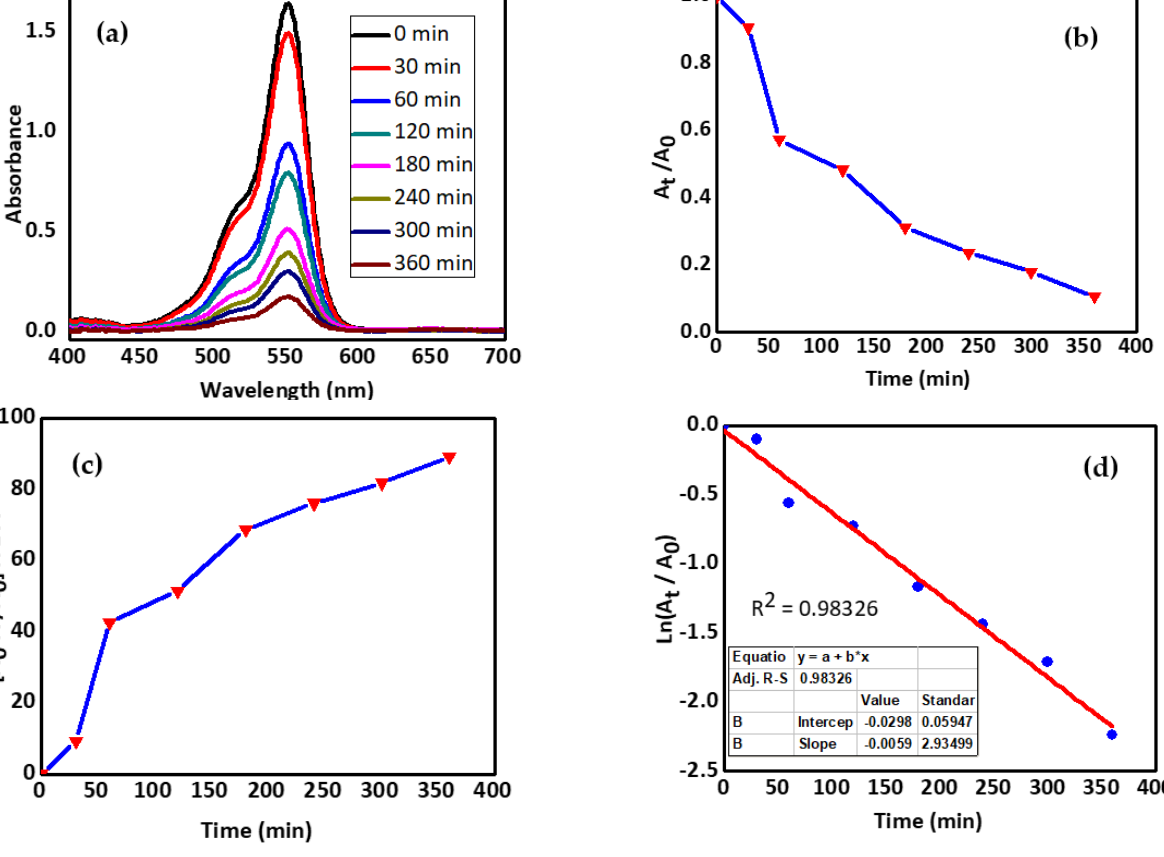
Figure 6. Degradation summary of RhB in the presence of 0.1 g CuO–SiO 2 particles under light. ( a ) Variation in UV-Visible spectra/absorbance at different intervals of time. ( b ) Ratio of absorbance (At/A 0 ) versus time. ( c ) Percentages of decomposition versus time. ( d ) Characteristic plot of pseudo- first-order kinetics of degradation.